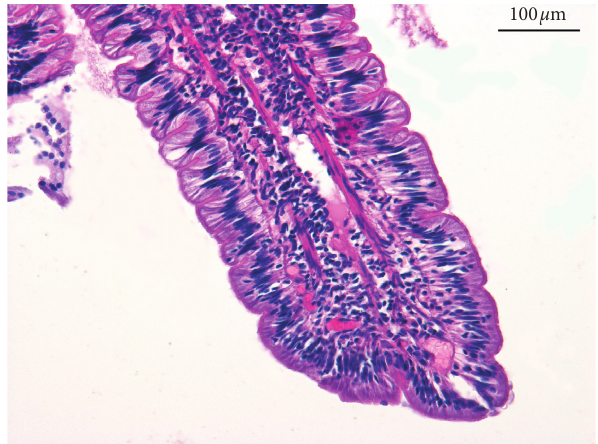
Figure 1: The microscopic view of infiltration of inflammatory cells observed in LPE.